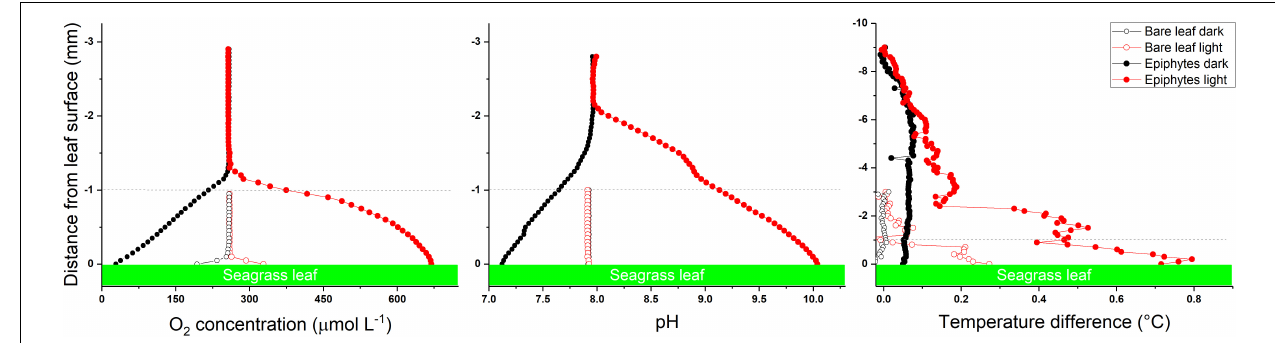
FIGURE 3 | Microsensor profiles of O 2 , pH and temperature at the surface of seagrass leaves with ( epiphytes ) and without ( bare leaves ) epiphytes. Data originates from Brodersen et al. (2020a) and Noisette et al. (2020). The dashed line at 1 mm distance from the leaf tissue surface marks the approximate thickness of the epiphytic biofilm layer. Red symbols and lines represent measurements in light. Black symbols and lines measurements in darkness. Microprofiling data of leaves with epiphytes show that in light the phyllosphere becomes hyperoxic, strongly basified and heated (solid red symbols as compared to open red symbols), whereas phyllopshere hyperoxia and acidification occurs in darkness (solid black symbols as compared with open black symbols); strongly affecting seagrass health and